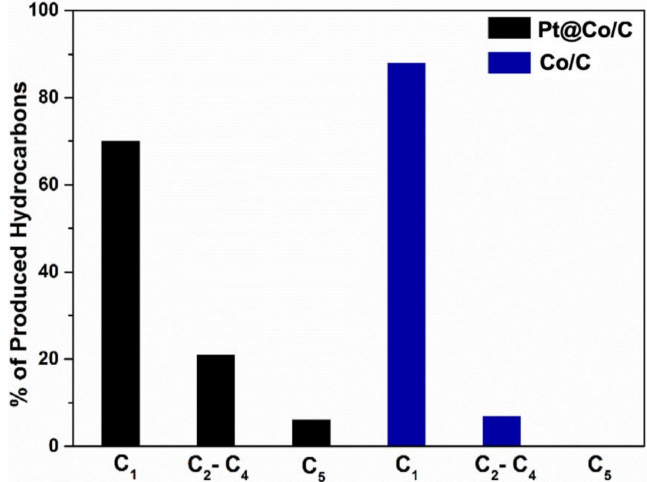
Figure 11. Selectivity for the hydrocarbons produced in FTS.